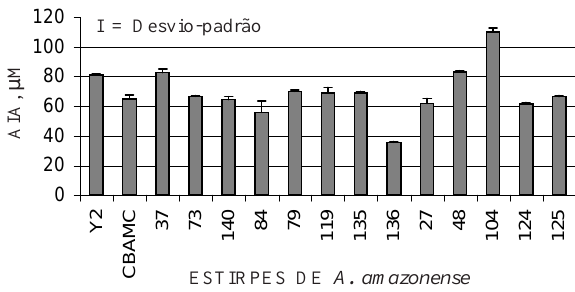
Figura 3. Produção de AIA por estirpes de referência de Azospirillum amazonense e por isolados de raízes de Brachiaria